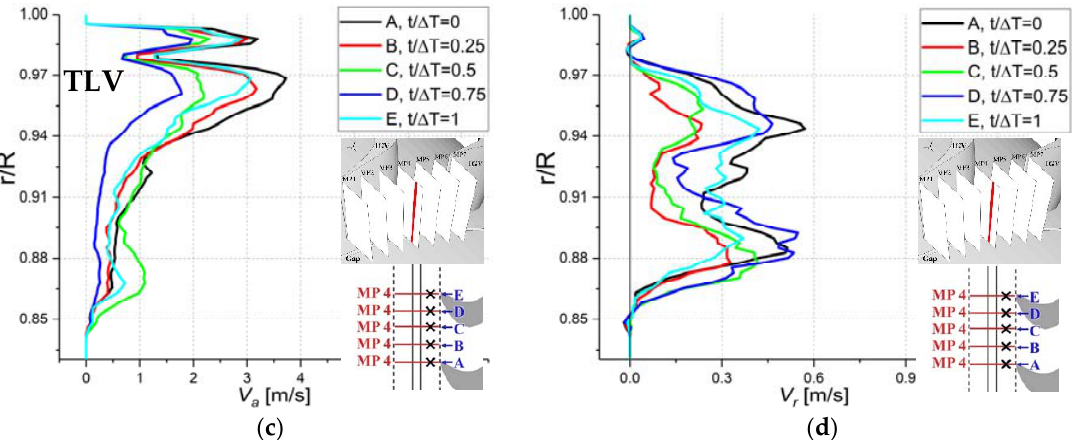
Figure 8. Velocity distributions at different rotor positions along annulus height in Case 2. ( a ) MP7, V a ; ( b ) MP7, V r ; ( c ) MP4, V a ; ( d ) MP4, V r .